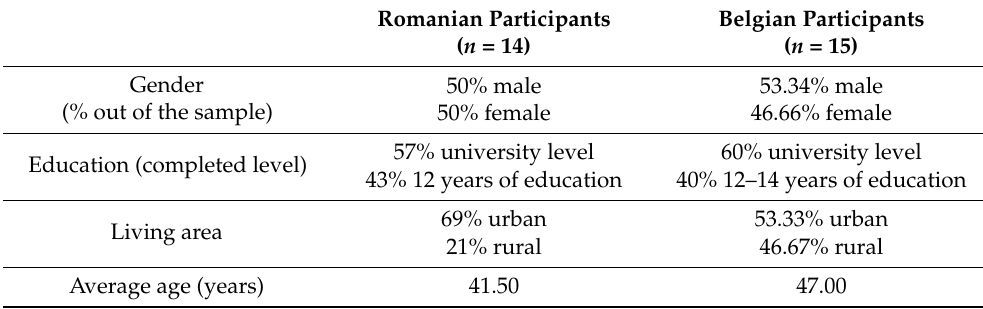
Table 2. Summary of demographic profile of Belgian and Romanian interview participants.